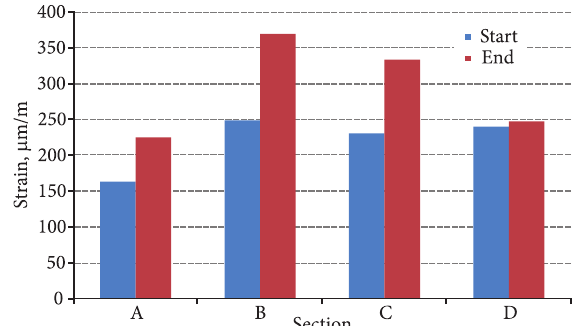
Fig. 8. Comparison of strains in the bottom of asphalt layers ( ε ye ) for wheel load 60 kN obtained in the beginning and at the end of HVS test